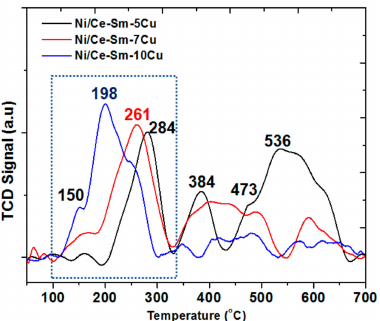
Figure 7. H 2 temperature-programmed reduction (H 2 -TPR) profiles of the Ni/Ce-Sm-xCu (x = 5, 7, and 10 at.%)